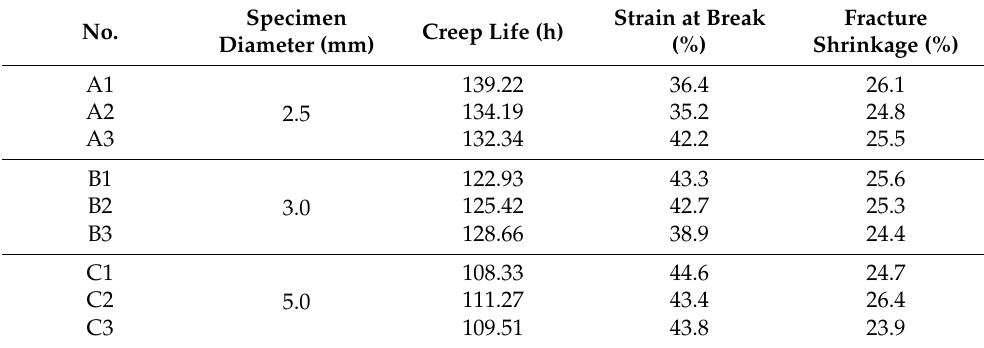
Table 2. Creep test results of three sizes of specimens at 980 ◦ C/300